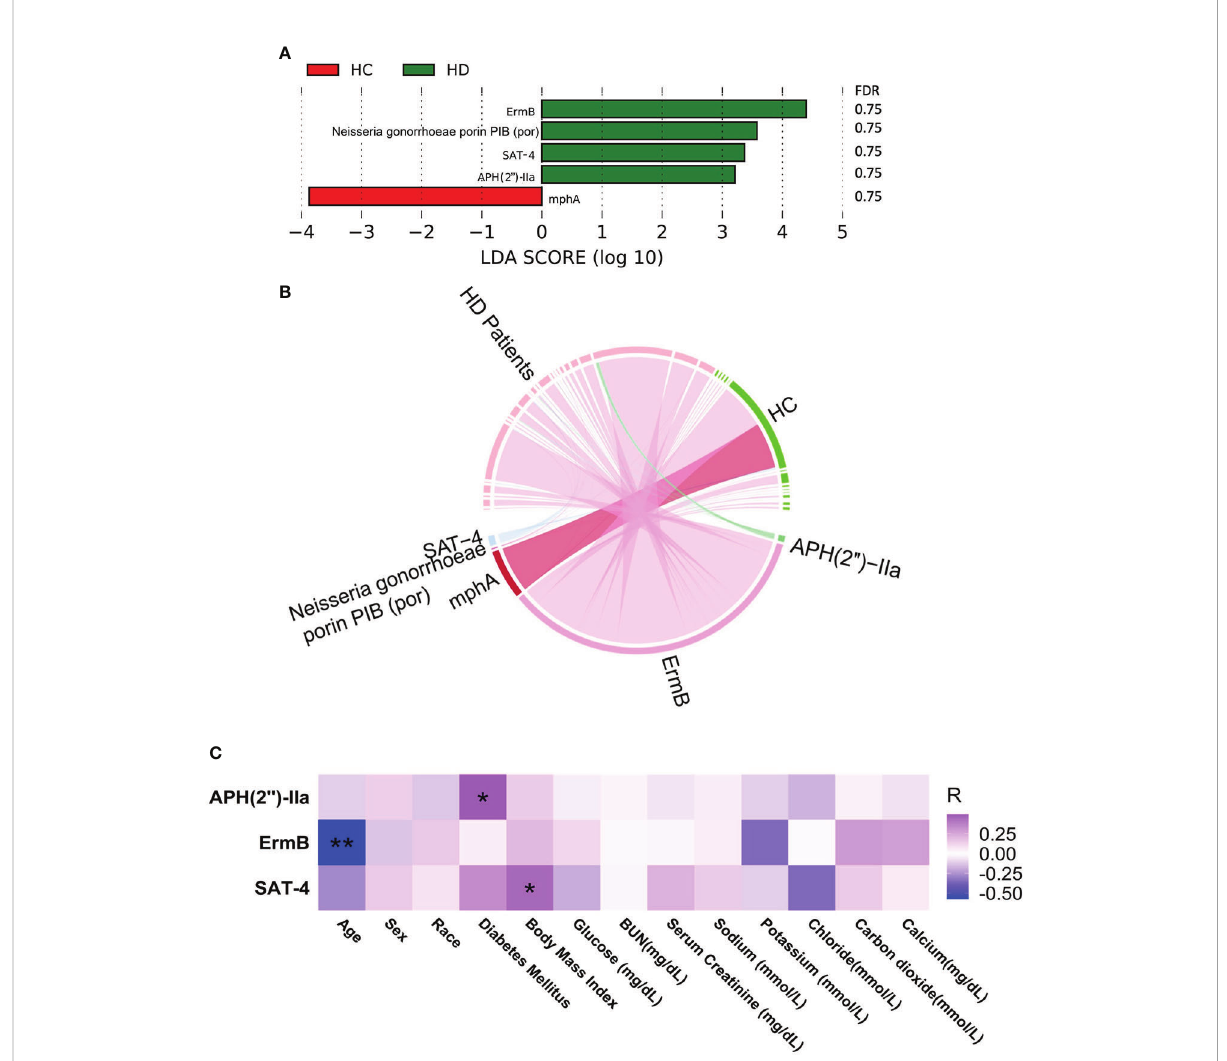
FIGURE 3 Alterations in virulence factors. (A) Signi fi cantly altered virulence factors between HD patients and control subjects. (B) Distribution of virulence factors in each sample. Data were visualized via Circlize package in R. (C) Correlations between virulence factors and clinical data. * p -value < 0.05; ** p -value < 0.01. BUN, blood urea